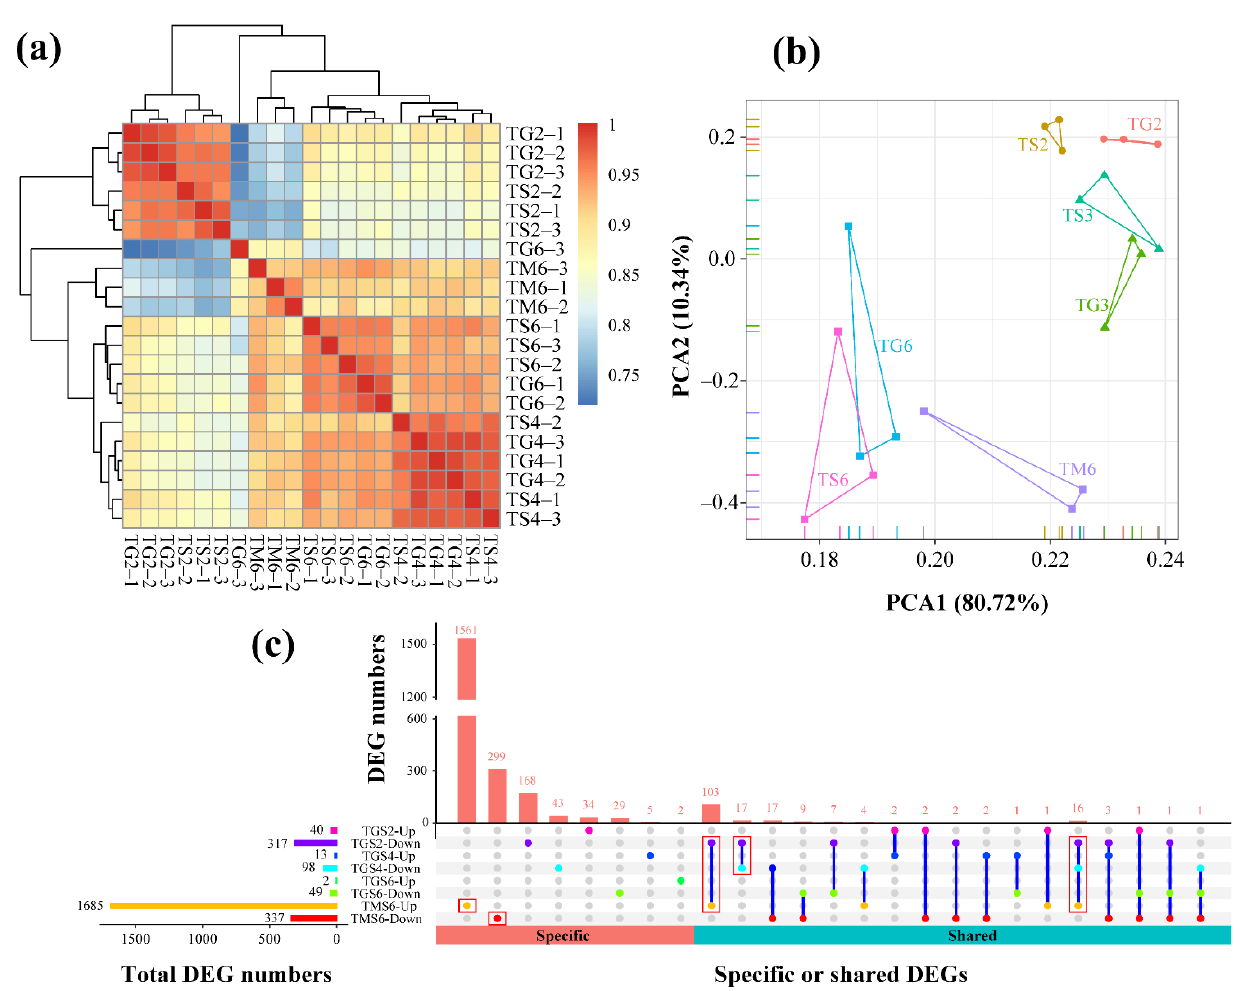
Figure 2. Correlation and differential gene expression analysis. ( a ) Heatmap of duplicate samples of different comparing groups of T. xiaojinensis . The color spectrum, ranging from blue through yellow to red, represents Pearson correlation coefficients ranging from 0.75 to 1, indicating low to high correlations. ( b ) Principal component analysis (PCA) of the transcriptome for different comparing groups of T. xiaojinensis . Different comparing groups are shown in different colors; T. xiaojinensis of different instars are indicated by different symbols. ( c ) UpSetR plots depict specific and shared DEGs among different comparing groups from T. xiaojinensis . Horizontal bars represent the total DEG numbers of each comparing group; vertical bars represent the unique and shared DEGs of different comparing group intersections. TGS2, TS2 vs. TG2; TGS4, TS4 vs. TG4; TGS6, TS6 vs. TG6; TMS6, TS6 vs.